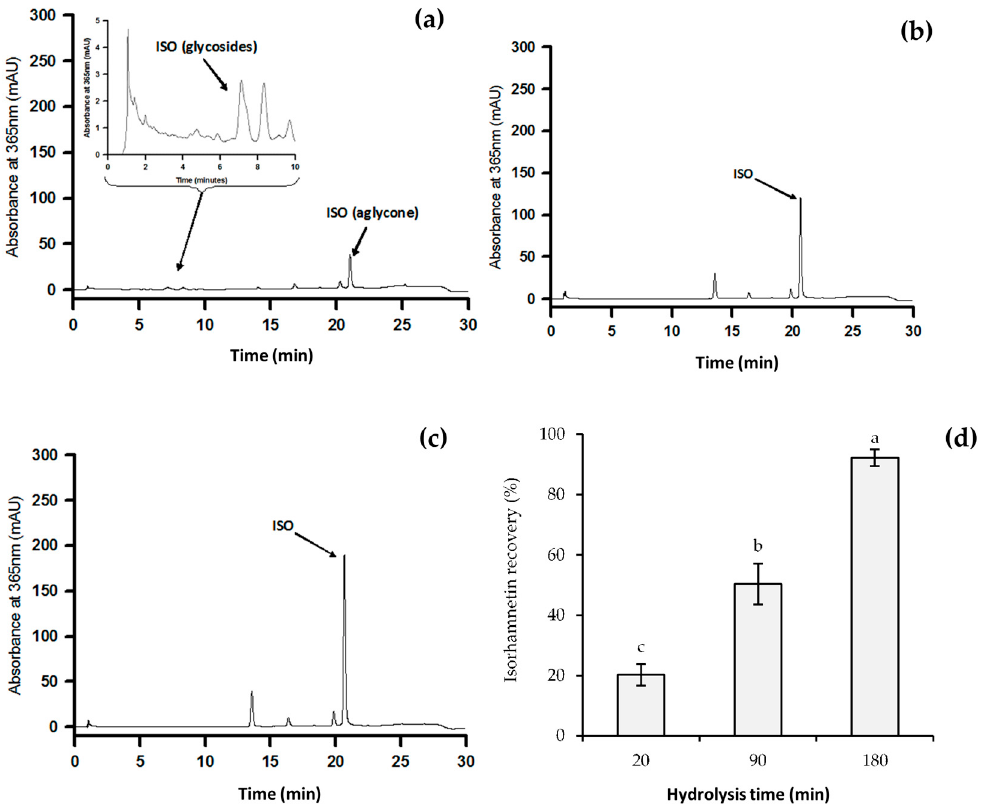
Figure 3. Chromatograms showing isorhamnetin release from isorhamnetin glycosides contained in O. ficus-indica extract, using ( a ) 20 min; ( b ) 90 min; or ( c ) 180 min of acid hydrolysis; ( d ) isorhamnetin recovery percentages obtained after 20, 90, or 180 min of acid hydrolysis. Different letters indicate significant differences among different isorhamnetin glycosides.